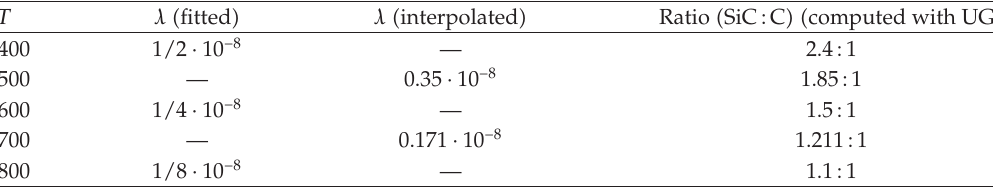
Table 5: Computed and experimental fitted parameters from UG simulations.